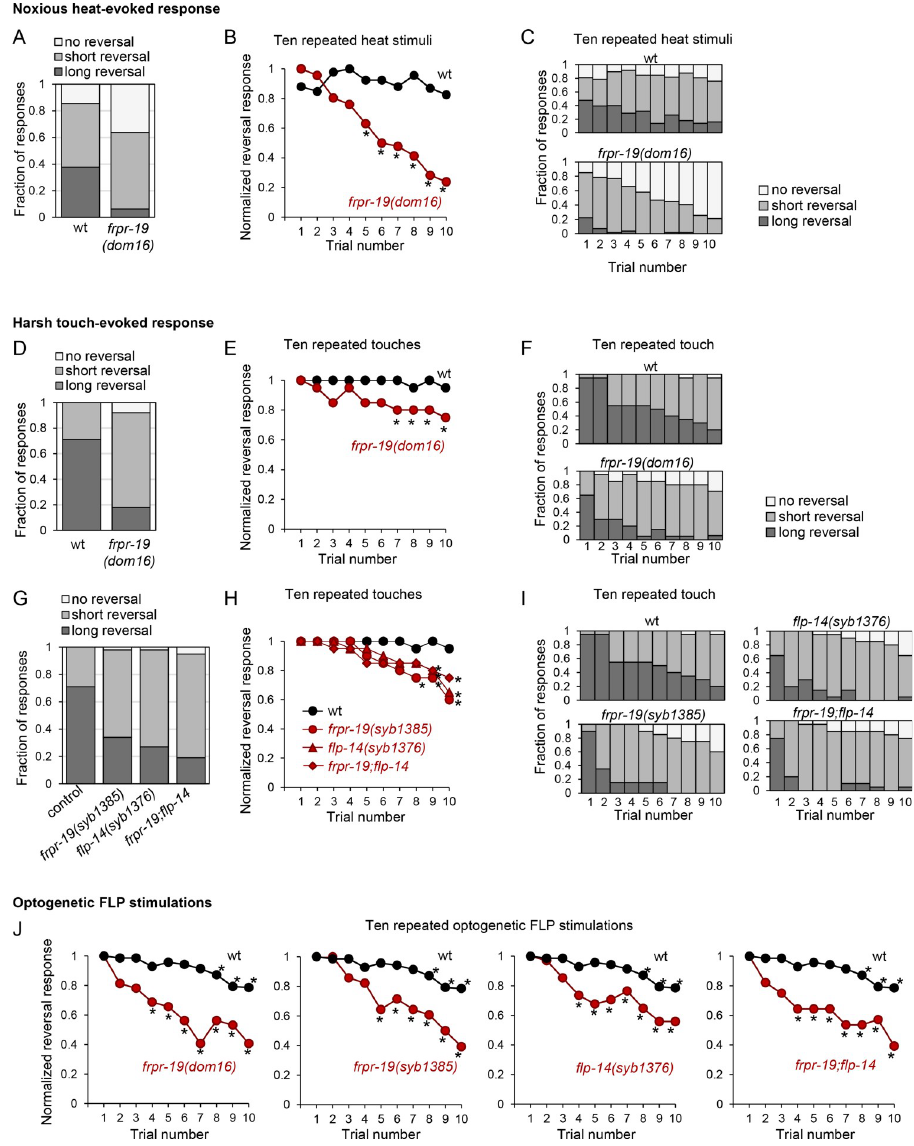
Fig 5. Mutations affecting the FLP-14/FRPR-19 pathway cause fast habituation of responses to noxious heat and harsh touch. (A, B, C) Impact of frpr-19 mutation on noxious heat-evoked reversals. Reversal length comparison, based on a five-trial assay (A) or across a longer habituation protocol of ten repeated stimuli (C). Normalized reversal response, expressed as fraction of the maximal response rate and showing faster habituation in frpr-19 mutant (B). (D-I). Impact of frpr-19 and flp-14 mutations on harsh touch-evoked reversals. Reversal length comparison, based on a five-trial assay (D, G) or across a longer habituation protocol of ten repeated stimuli (F, I). Normalized reversal response, expressed as fraction of the maximal response rate and showing faster habituation in frpr-19 mutant (E, H). (J) Impact of frpr-19 and flp-14 mutations on optogenetic FLP stimulation-evoked reversals in a ten-stimuli habituation protocol, showing a faster habituation in the mutants. � , p < .01 versus corresponding wild type data point by Bonferroni contrasts (B, E, H, J). The data without normalization corresponding to panels B, E, H and J are presented in S3